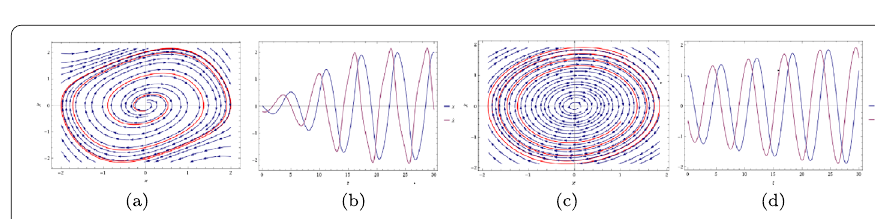
Figure 2 Solutions of (8) for different values of σ (1 – μ ). We see that the solution for these cases is cyclic